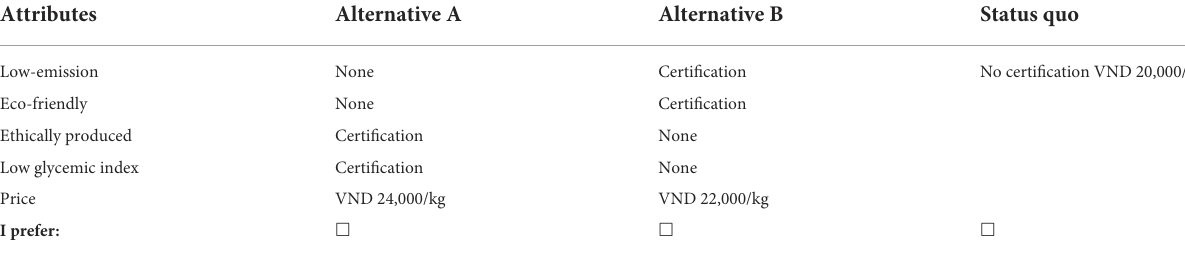
TABLE 2 Example of choice